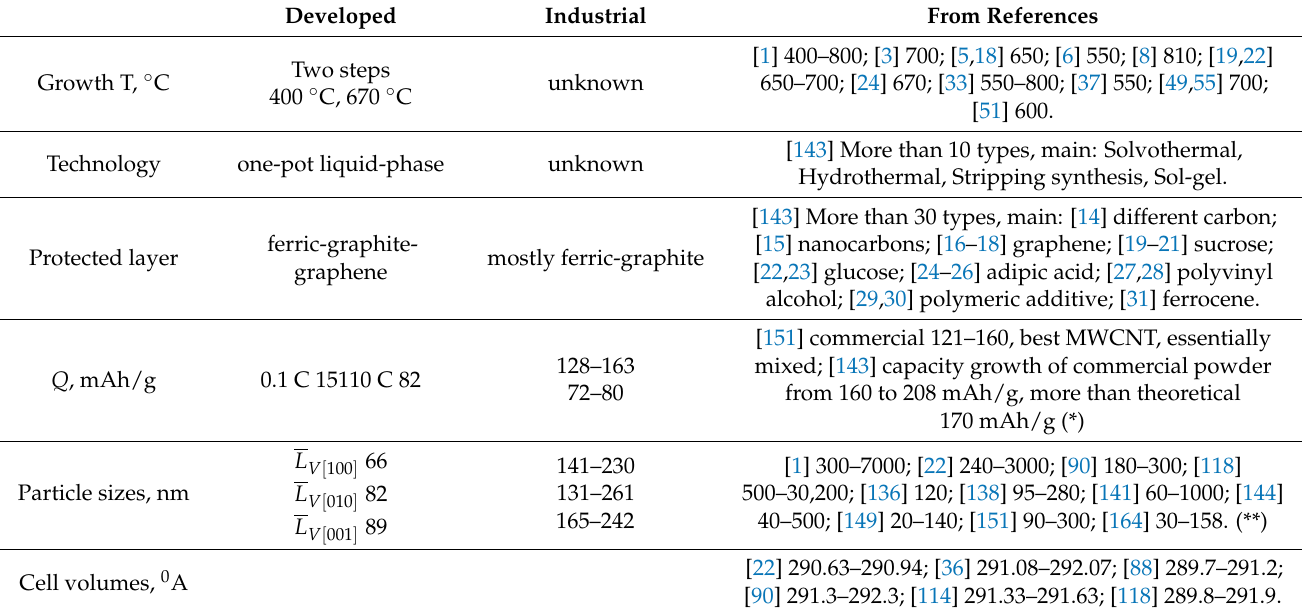
Table 7. Parameters of LiFePO4 powders: developed, studied industrial and described in the references, as well as comments on the comparison